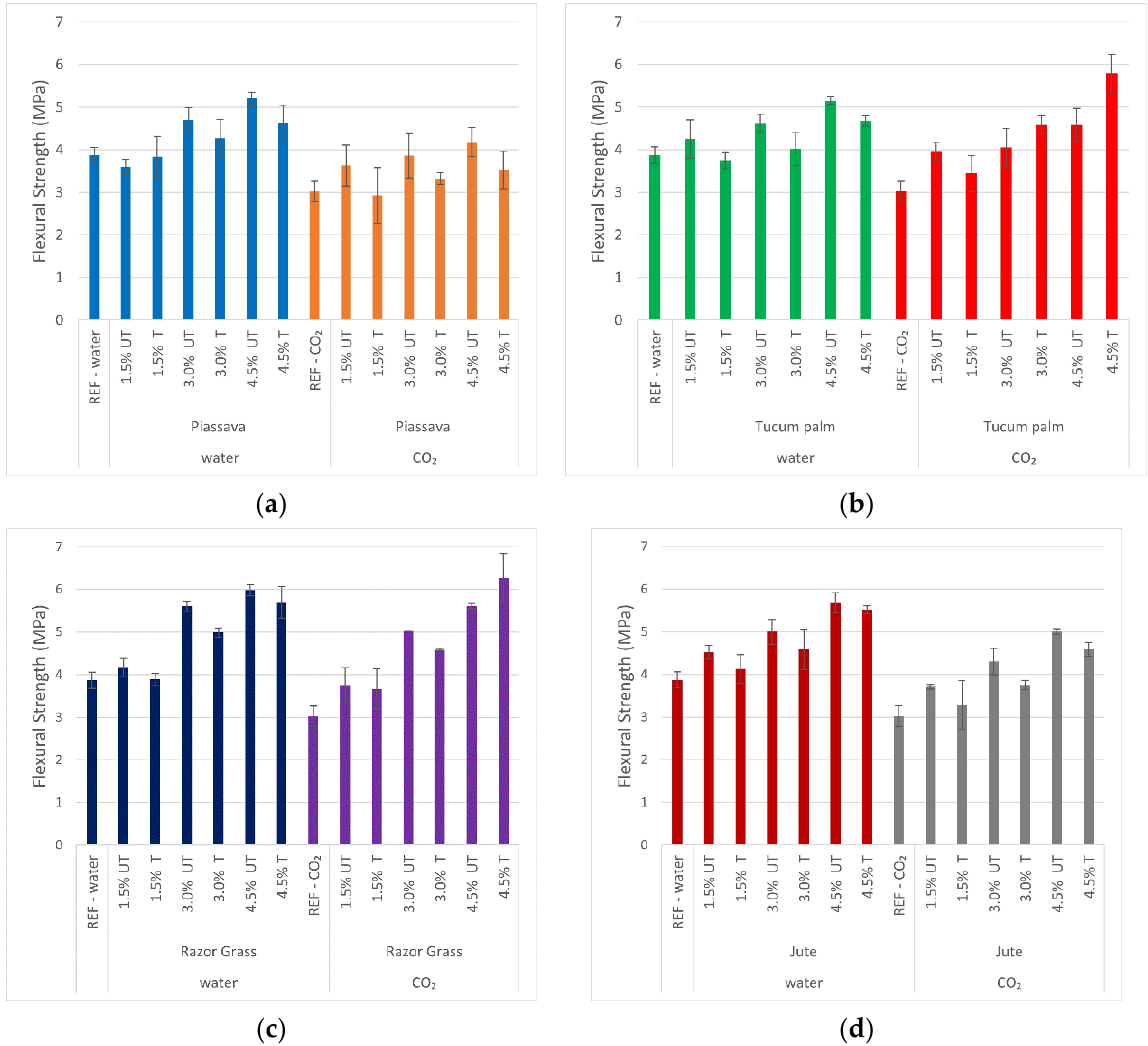
Figure 9. Flexural strength of mortars at 28 days obtained with samples cured with water and CO 2 : ( a ) 1.5%; 3.0%; 4.5% piassava mortars; ( b ) 1.5%; 3.0%; 4.5% tucum palm mortars; ( c ) 1.5%; 3.0%; 4.5% razor grass mortars; ( d ) 1.5%; 3.0%; 4.5% razor grass mortars; REF — specimen without fiber ; UT — untreated fiber mortar; T — treated fiber mortar; water and CO 2 — cured methods.